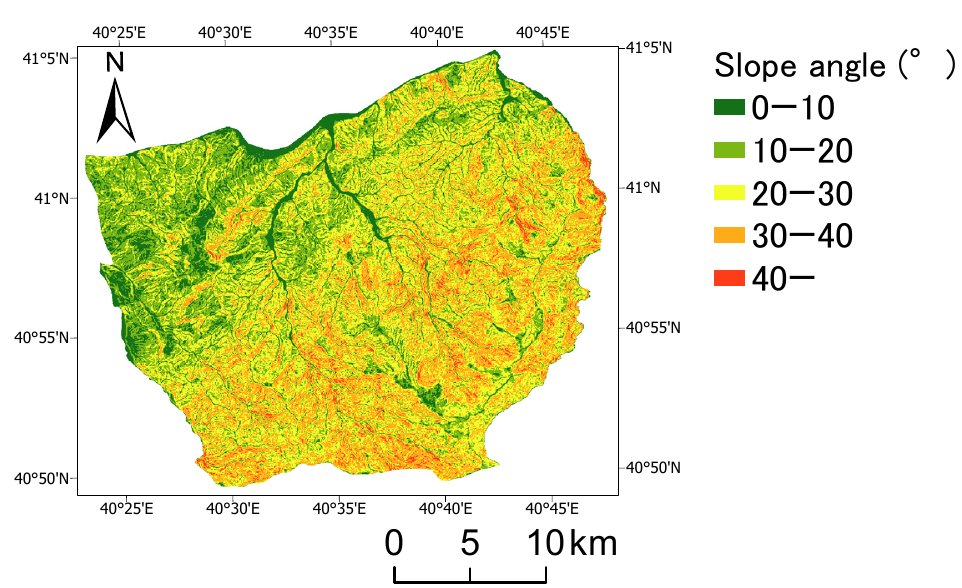
Figure 2. Distribution of the slope angle in the study area.